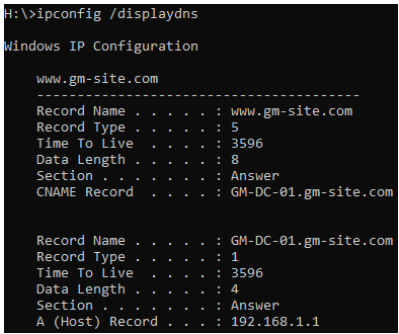
Figure 7. DNS record displayed on the client